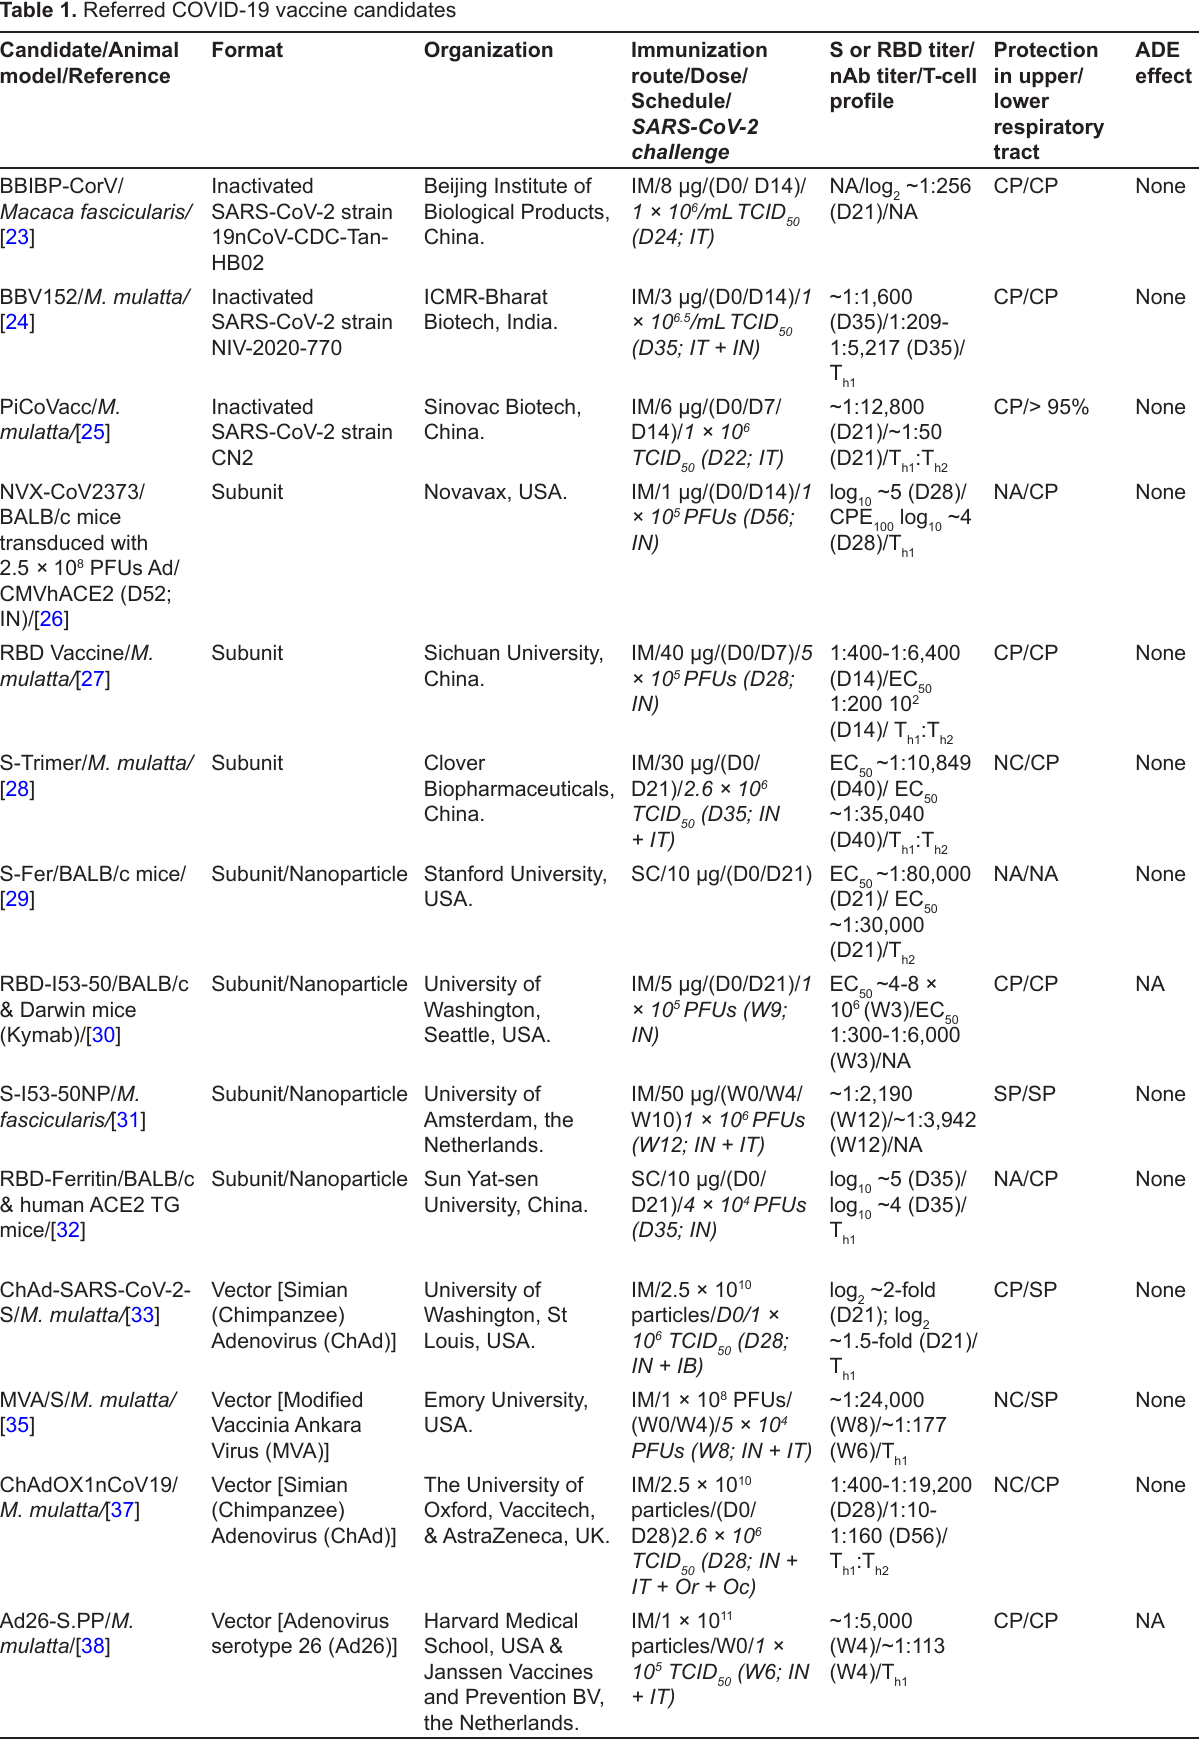
Table 1. Referred COVID-19 vaccine candidates Candidate/Animal